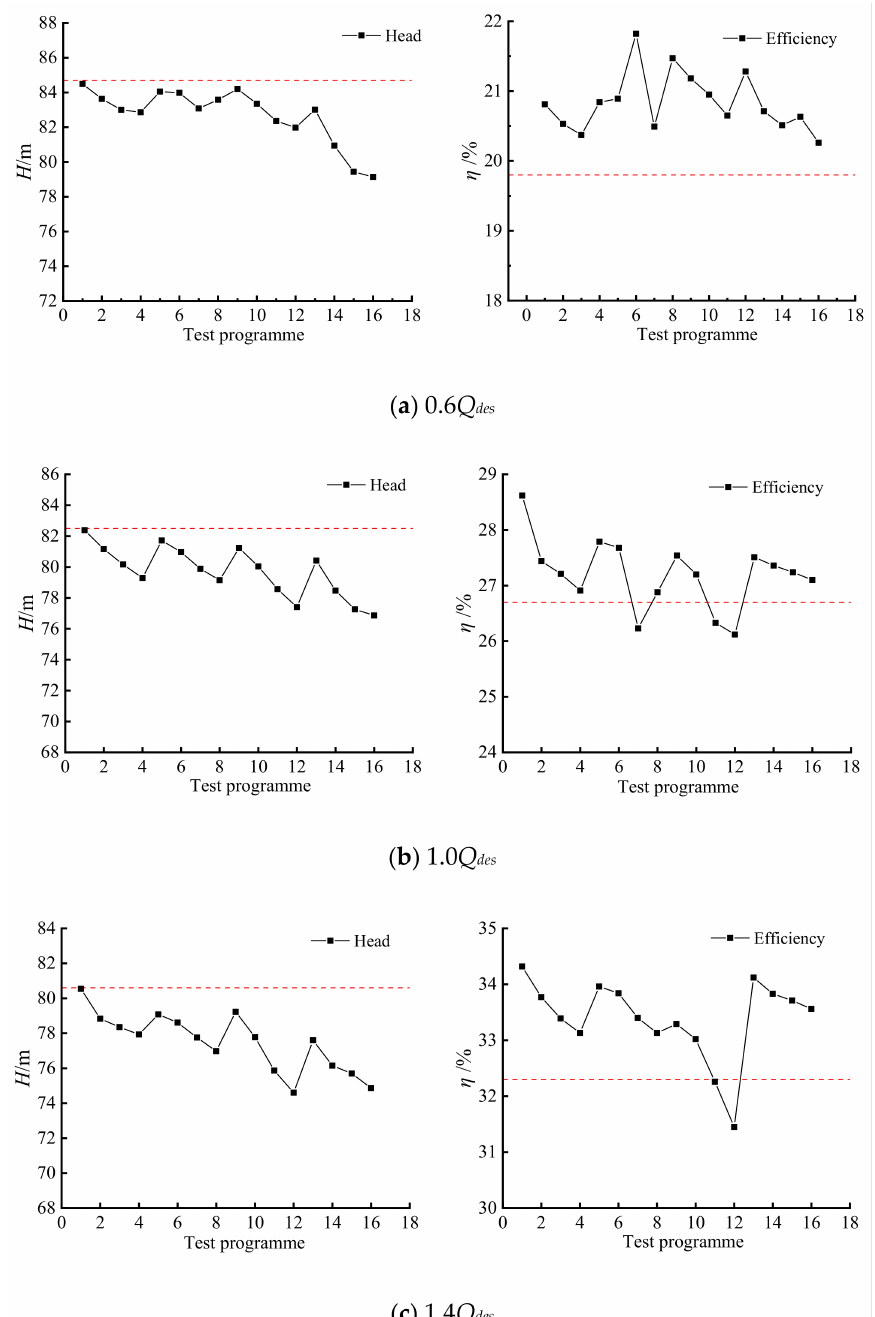
Figure 6. Performance of orthogonal